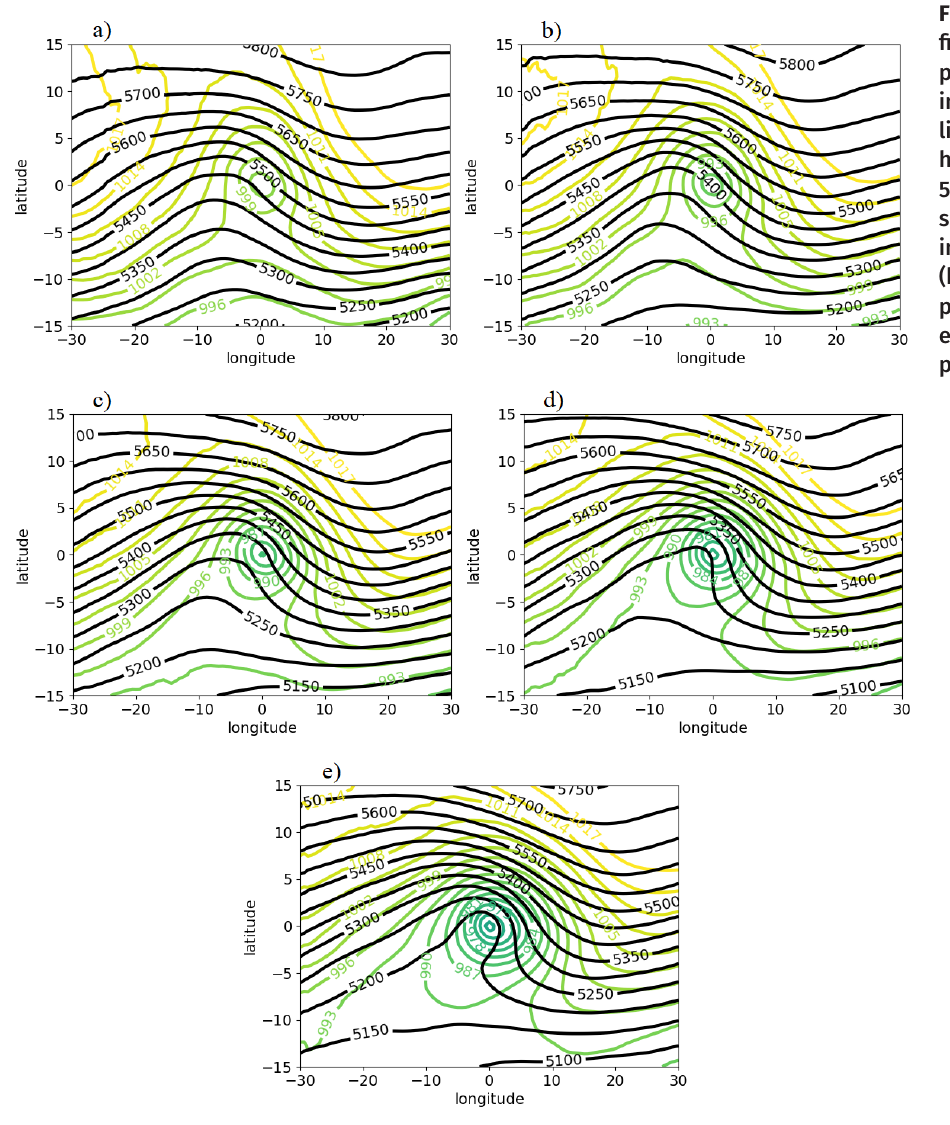
Figure 6. Composite fields of mean sea level pressure with 3 hPa intervals (colored solid lines) and geopotential height at 500 hPa with 50 gpm intervals (black solid lines) for non- intense cases: a)